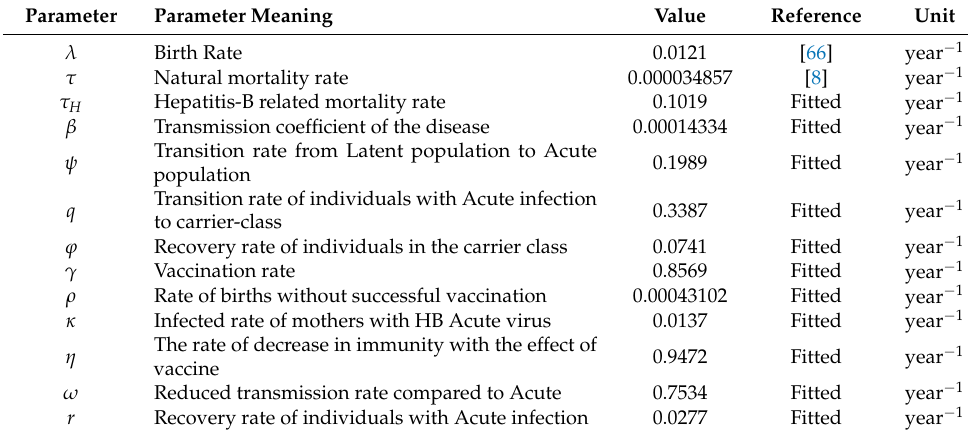
Table 1. Estimated values of the